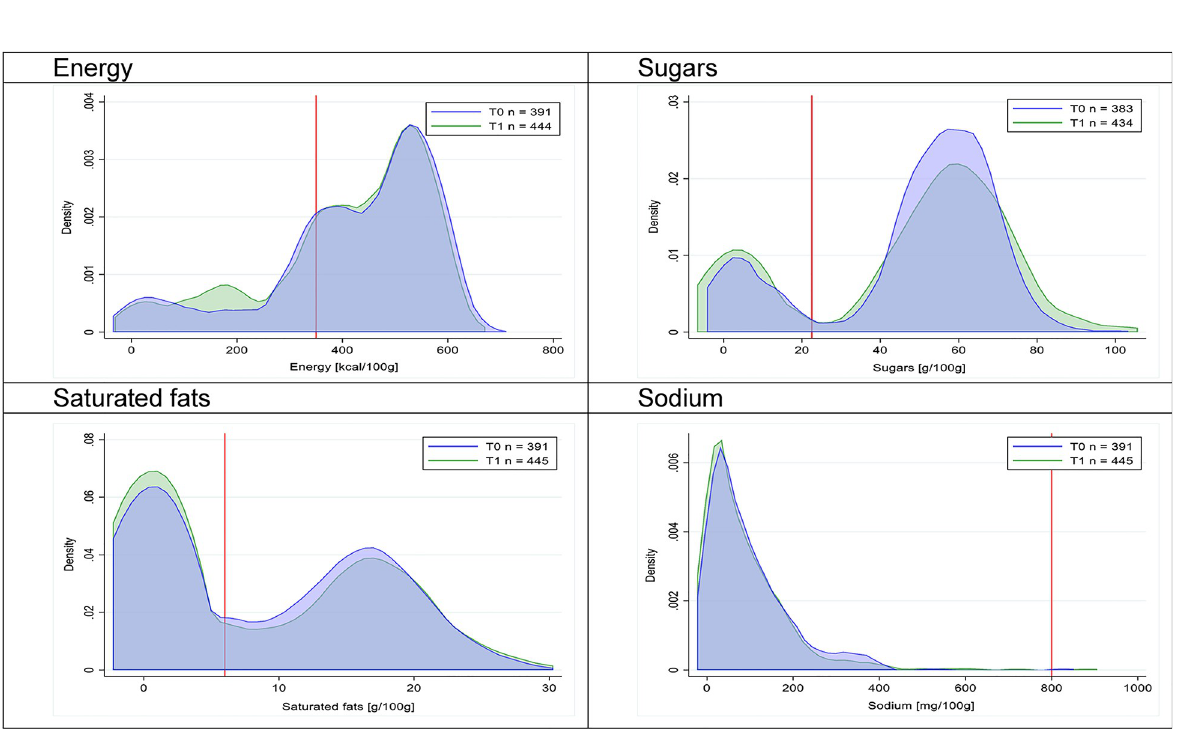
Fig 8. Density curves for the amount of energy and nutrients of concern in candies and sweet confectioneries, cross-sectional samples. The blue line represents the distribution in T0 (preimplementation), the green line represents the distribution in T1 (postimplementation), and the red line represents the cutoff for the amount of energy or nutrients of